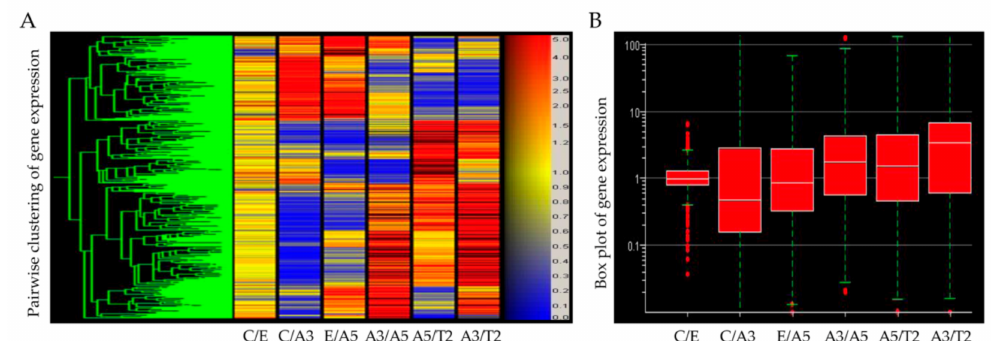
Figure 2. Heatmap of Affymetrix array (U133A) data that allows to compare the following cell lines: MCF-10F (C) /Estrogen (E); C/Alpha3 (A3); E/Alpha5 (A5); A3/Alpha5; A5/Tumor2 (T2) and A3/T2 [153]. The red color indicates a higher expression in the first cell line, blue a lower expression, and yellow equal expression in both cell lines ( A ). The box plot of the gene summarizes the range of differential gene expression in the same pairwise cell line comparisons ( B ).